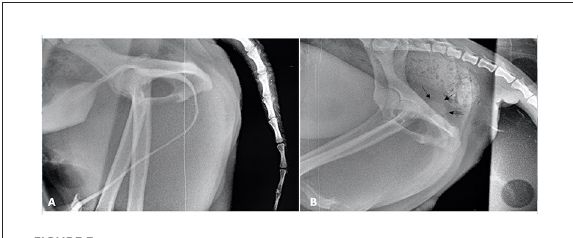
FIGURE3 (A) Contrast cystogram performed after the first intervention. (B) Contrast cystogram performed with manual compression of the bladder. Note the pre-stenotic bulge of the pelvic urethra (black arrows).